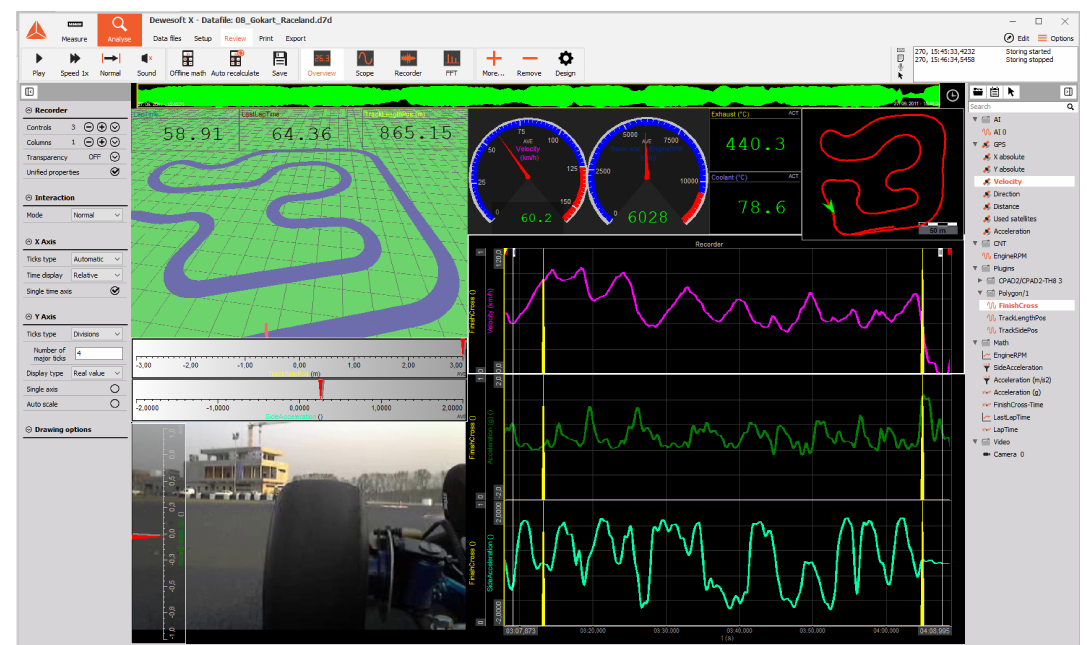
Figure 2. Execution of measurement procedure developed in